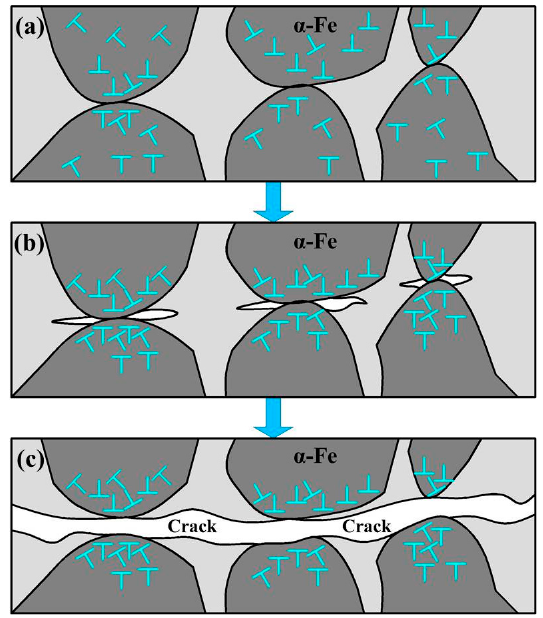
Figure 10. Schematic diagram of the crack initiation mechanism: ( a ) a large number of dislocations in the α‐ Fe phases; ( b ) dislocations accumulation at the boundary of two α‐ Fe phases and the initiation of the crack; ( c ) crack propagates along the Cr 23 C 6 phase.